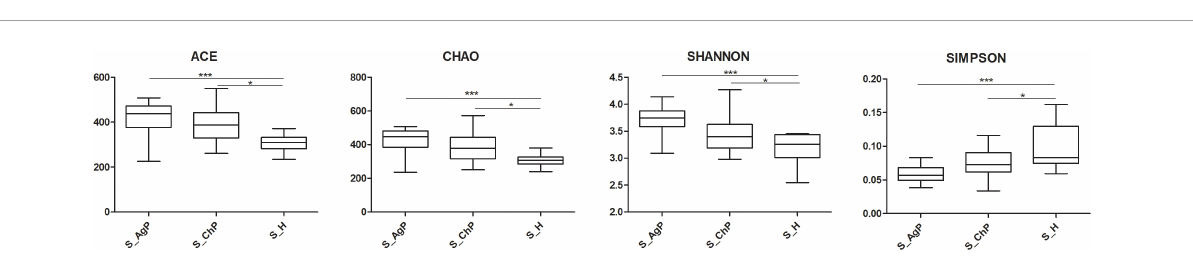
FIGURE2 Alpha diversity indexes of microbial communities in three groups. The alpha diversity of microbiota as calculated by ACE index, Chao index, Shannon index, and Simpson index of saliva samples in aggressive periodontitis group (S_AgP), chronic periodontitis group (S_ChP), and healthy group (S_PH). The error bars indicate mean with standard error. * p < 0.05; *** p < 0.001.